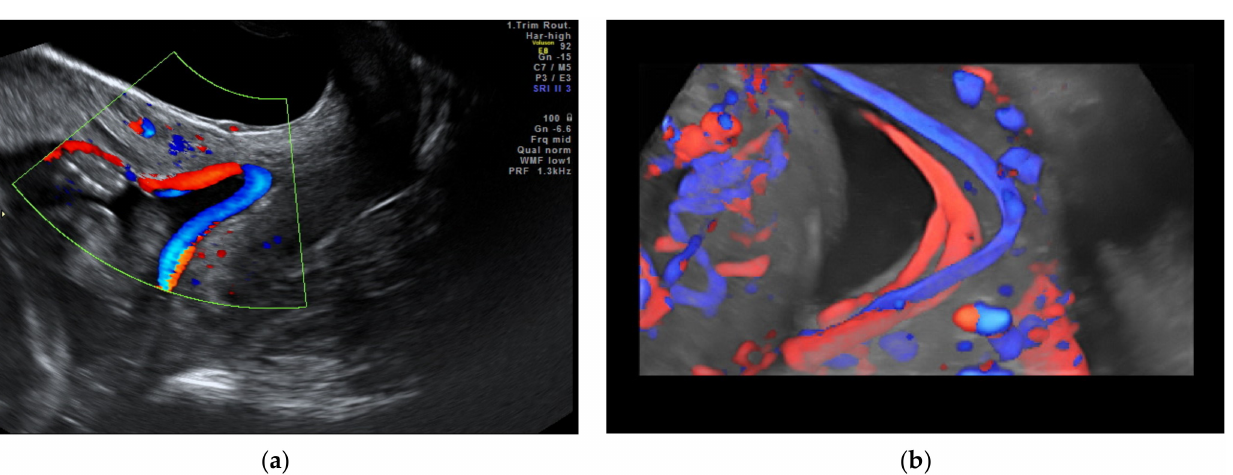
Figure 2. Vasa praevia as ( a ) 2D color Doppler ultrasound image and ( b ) 3D Static HD Flow imaging. Three types of vasa praevia are described: type 1, resulting from velamentous cord insertion; type 2, presented in patients with bilobed or succenturiate lobed placenta;